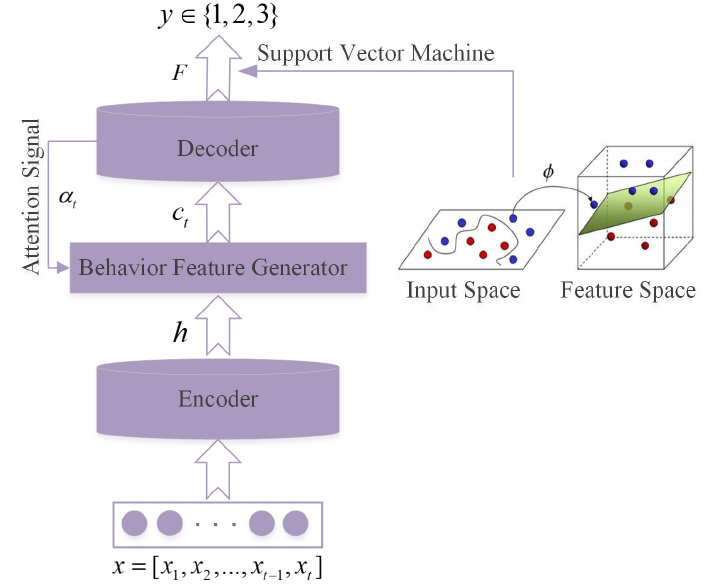
Figure 1. The general framework and dataflow of SPC for student